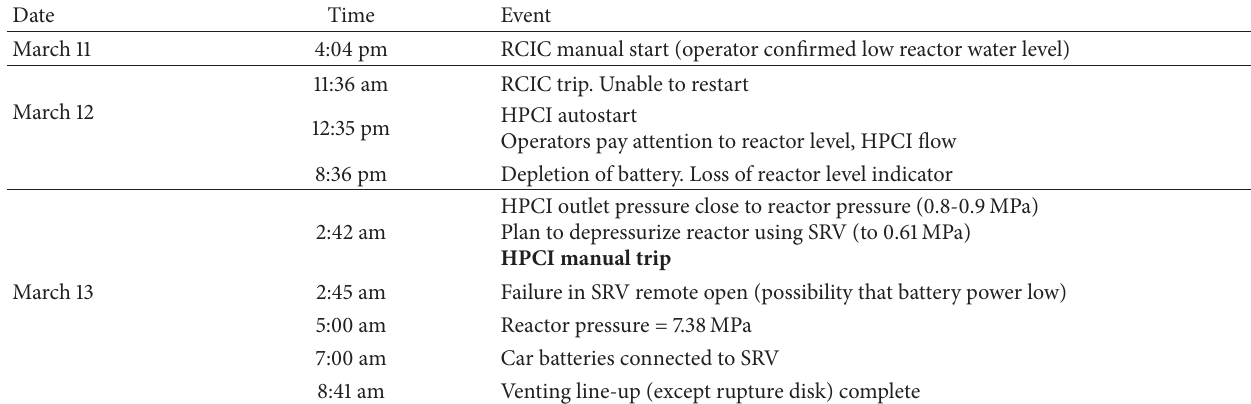
Table 3: Records related to manual trip of HPCI in Unit